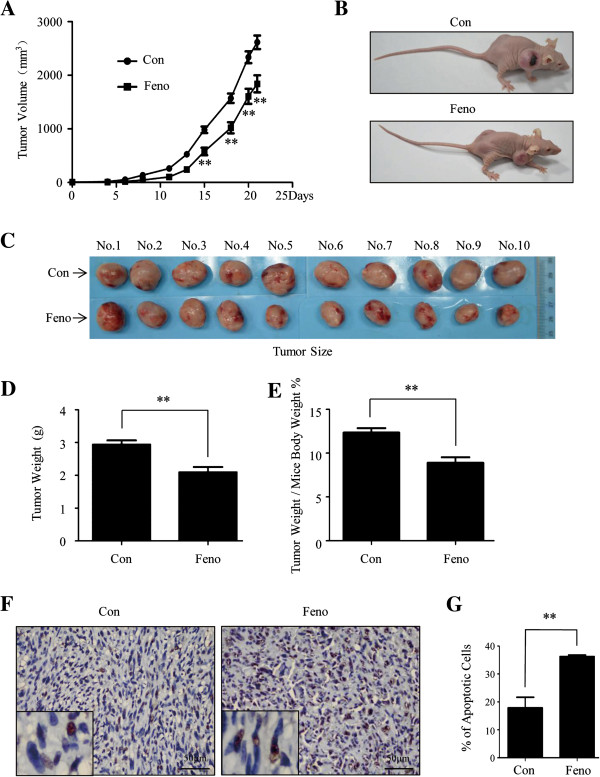
Fenofibrate slow down the growth of xenograft model of triple-negative breast cancer by inducing apoptosis. (A) Tumor volume with days after treatment. The volumes of tumors in the two groups reached a significant difference 15 days after fenofibrate treatment (** indicates p < 0.01 relative to the control group). (B, C) The tumor sizes in the treatment group were significantly smaller than that of the control group at the end of the study. (D, E) The tumor weight and the percentage of tumor weight/ mice body weight of the treatment group were significantly lighter than that of the control group (** indicates p < 0.01 relative to the control group). (F, G) The analysis of paraffin-embedded human breast cancer tissue from nude mouse models by TUNEL assay. Compared with the control group, TUNEL assay showed an increased number of apoptotic cells in fenofibrate treatment group (** indicates p < 0.01 relative to the control group). Feno = fenofibrate, Con = control.